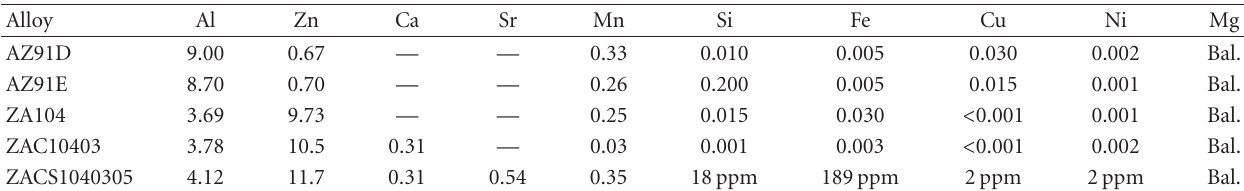
Table 1: Chemical composition (wt%) ∗ of the magnesium alloys